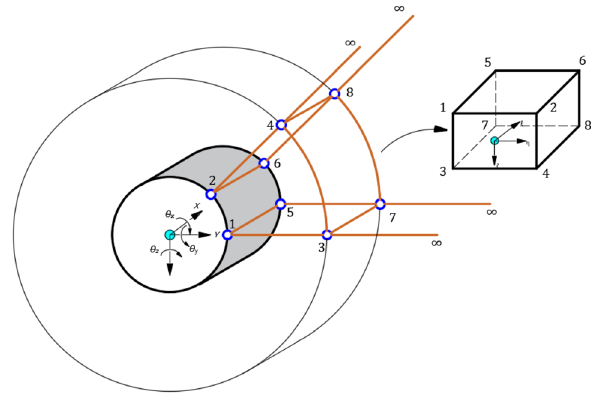
Fig. 4 Infinite element for modelling the soil boundary of the